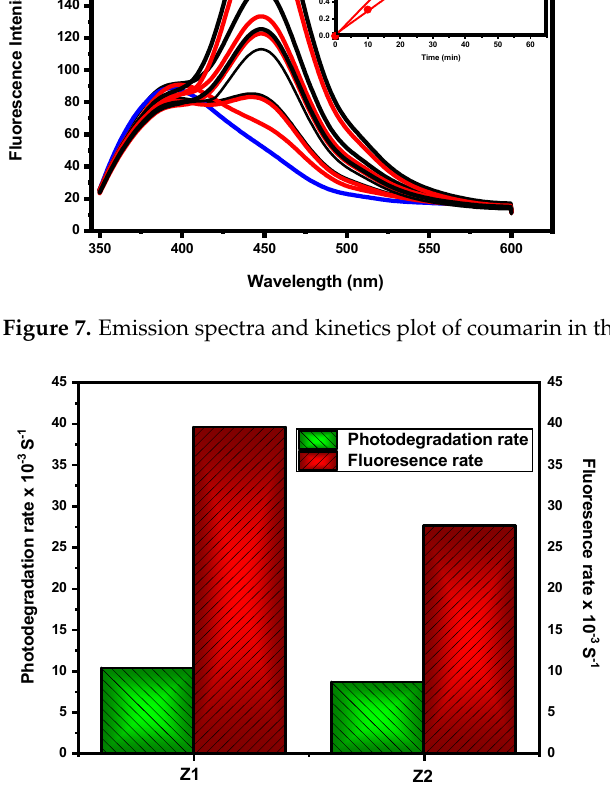
Figure 8. Correlation between photodegradation rate and fluorescence rate for ZQDs.